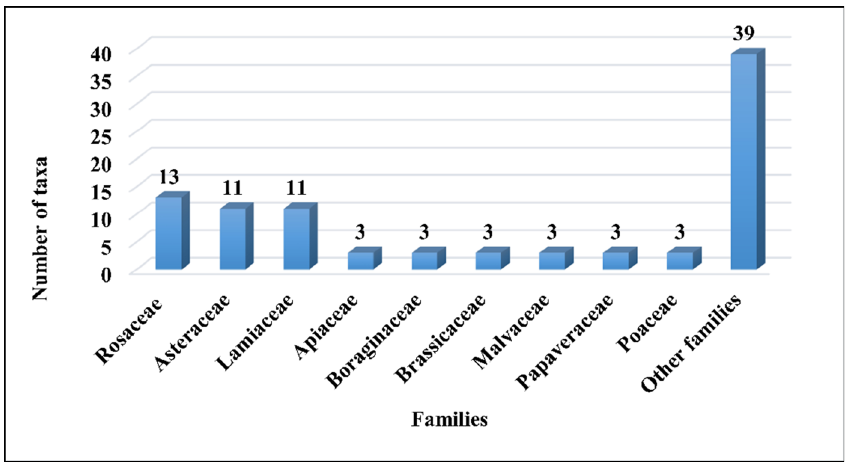
Figure 3: The most - cited plant families.